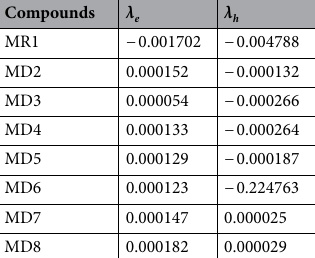
Table 4. Computed reorganization energies of MR1 and MD2 – MD8 chromophores.